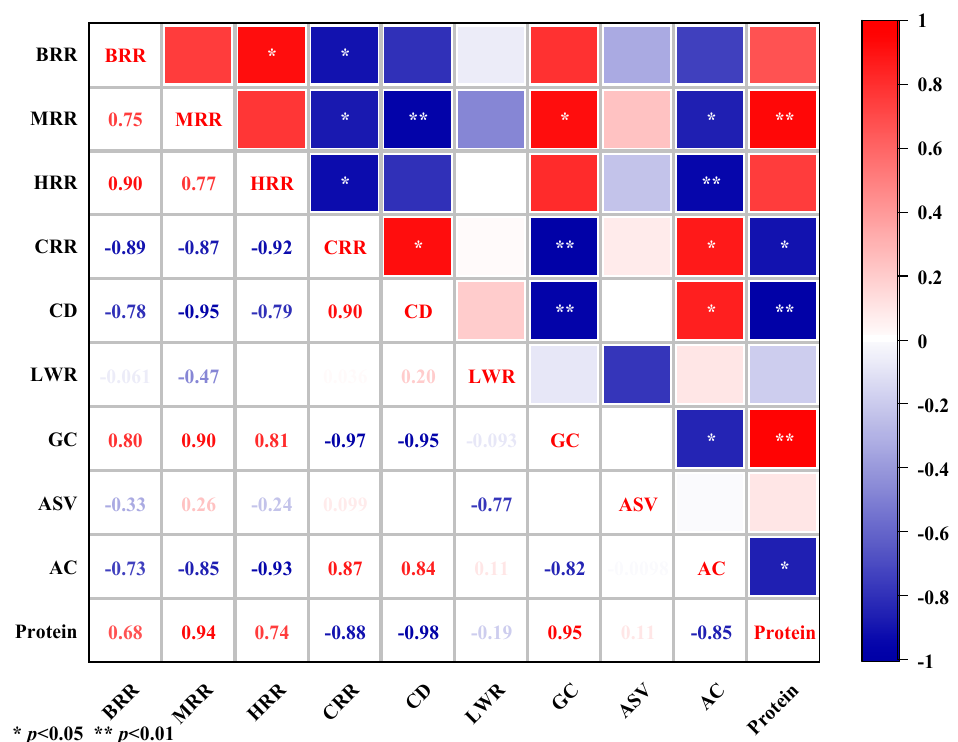
* p <0.05 ** p <0.01 Figure 11. Correlation of rice quality indicators. BRR, brown rice rate; MRR, milled rice rate; HRR, head milled rice rate; CRR, chalky rice rate; CD, chalkiness degree; LWR, length–width ratio; GC, gel consistency; ASV, alkali spreading value; AC, amylose content. The correlations of rice quality indicators in this study were evaluated by using Pearson correlation analysis, with a significance level at p < 0.05 or p < 0.01. n = 40. Table 4. Ecosystem service value (¥ hm − 2 year − 1 ) of each Table 3. Effects of different systems on the annual yield and economic benefit of paddy fields. Treatm Rice ent